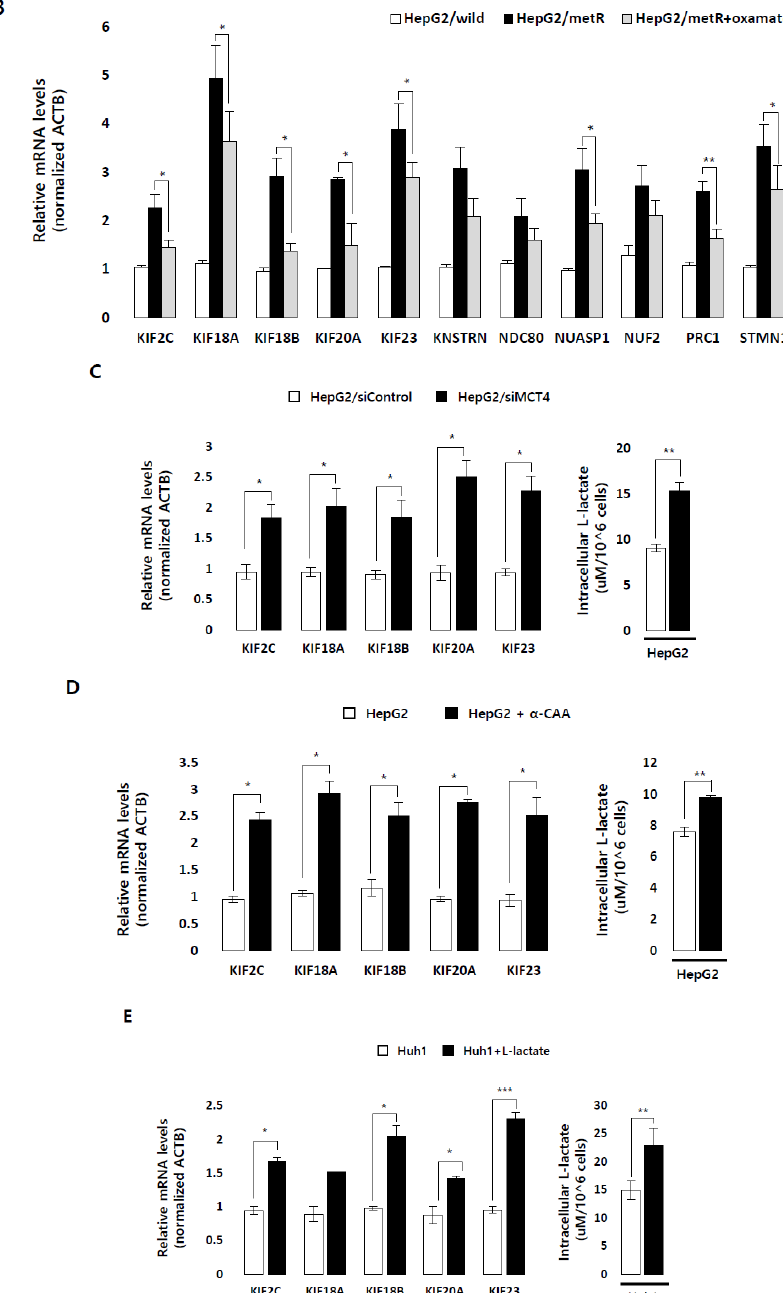
Figure 2. Lactate-enriched microenvironment up-regulates the expression of genes modulating cell-cell or cell-matrix communications. ( A ) Pathways potentially regulated by 136 top-ranked lactate-responsive genes were identified in silico through a literature mining process provided by Pathway Studio